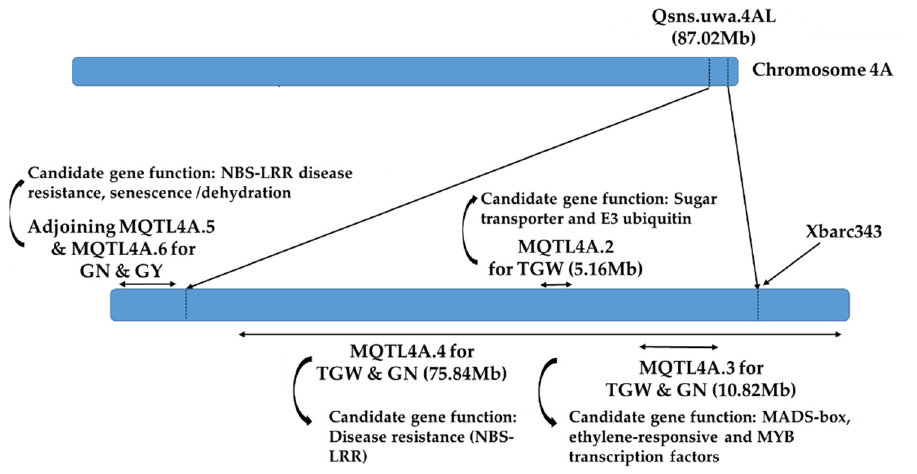
Figure 4. Conceptual framework of the meta QTLs (MQTLs) [32] reported in the targeted 4A locus. MQTL4A.2, MQTL4A.3 and MQTL4A.4 were found overlapping with the 4A locus, and MQTL4A.5 MQTL4A.2, MQTL4A.3 and MQTL4A.4 were found overlapping with the 4A locus, and